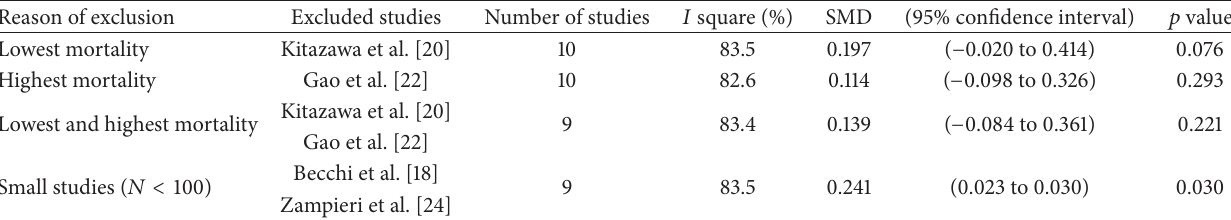
Table 3: Sensitivity analysis of possible heterogeneity studies.